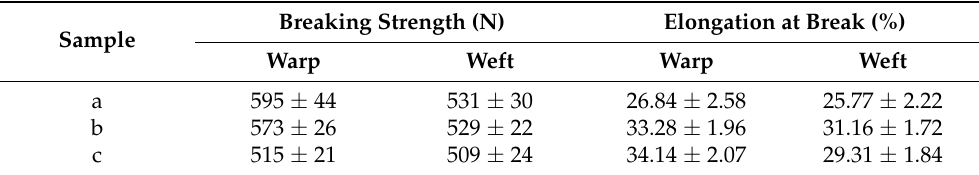
Table 2. Comparisons of the mechanical properties of the fabric.